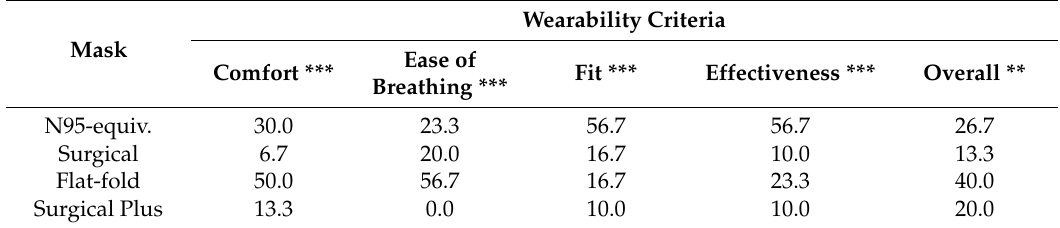
Table 2. Mean (Standard Deviation) scores (out of 5) for each mask and wearability criteria. Mask Comfort Hotness Humidity N95-equiv. 3.0 (1.5) Surgical 2.9 (1.0)